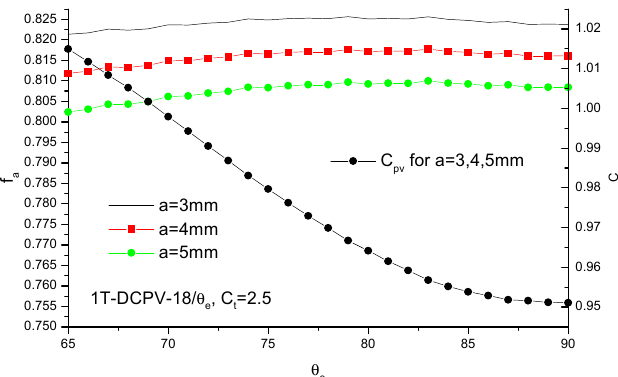
Figure 23. Effects of solar cells’ size on the performance of 1T-DCPV-18/ θ e Figure 23 . Effects of solar cells’ size on the performance of 1T-DCPV-18/ e Figure 23 . Effects of solar cells’ size on the performance of 1T-DCPV-18/ e